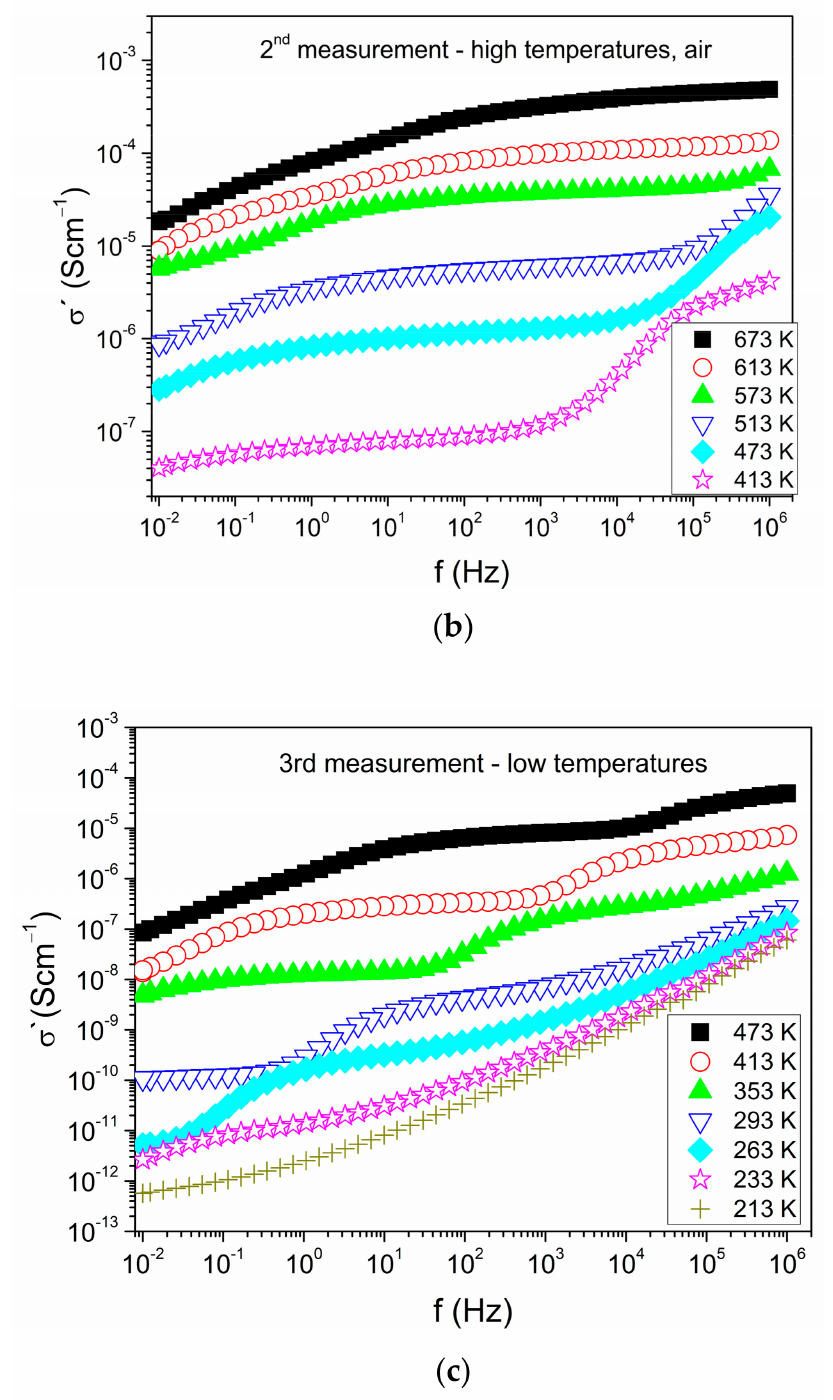
Figure 1. The frequency dependence of the real part of the AC conductivity at different temperatures: ( a ) First measurement at low temperatures, ( b ) second measurement at high temperatures and air atmosphere, and ( c ) third measurement at low temperatures. All measurements were conducted during